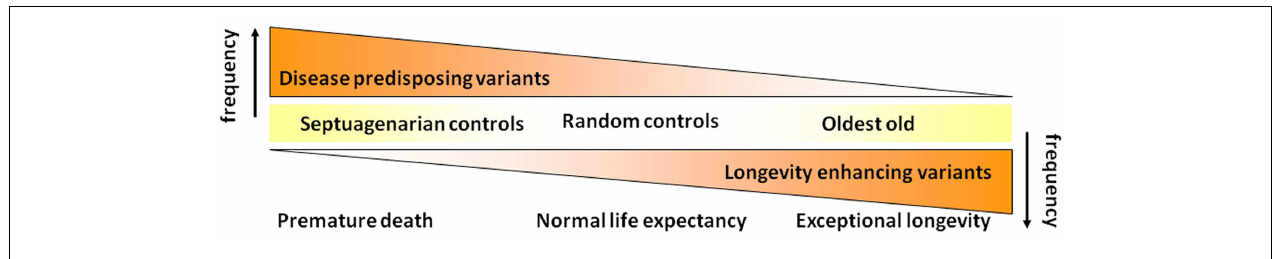
FIGURE 2 | Initial hypothesis on the genetic basis of exceptional